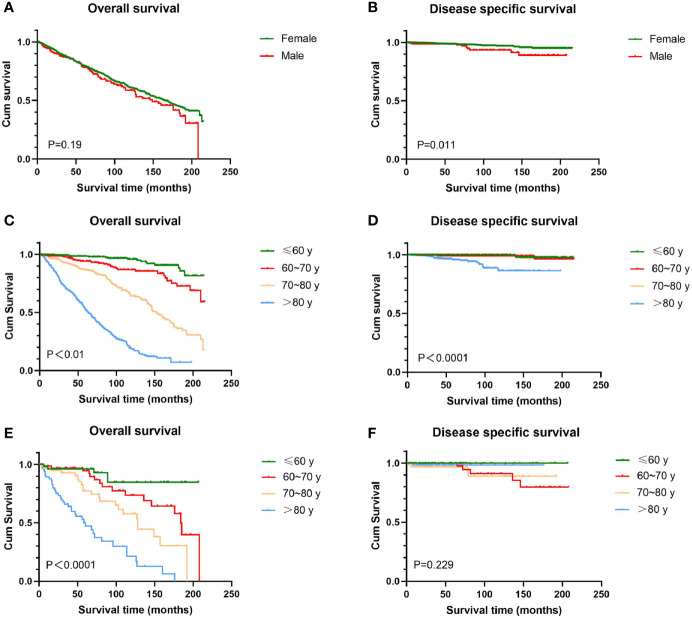
Kaplan-Meier estimates of OS and DSS by sex and age. There was no significant difference in OS between female and male (A), while female experienced higher DSS than men (B). OS decreased as age increased irrespective of sex (C, E). Female over 80 years had significantly worse DSS than other age groups (D); for male, difference in DSS between ages does not reach significance (F). OS, overall survival; DSS, disease-specific survival; BCC, basal cell carcinoma.